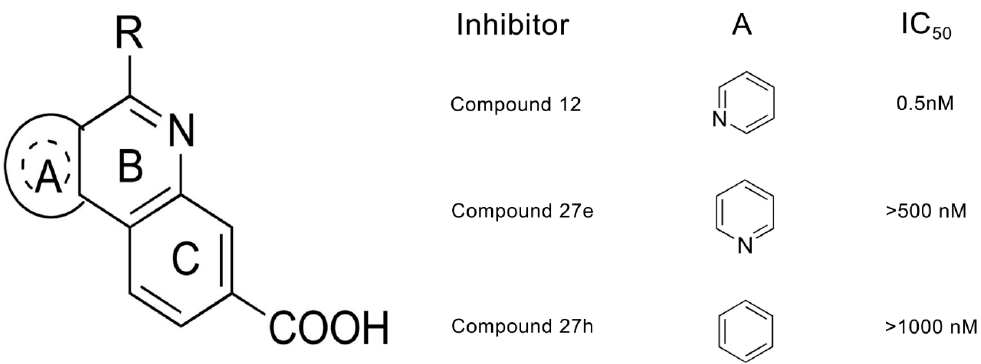
Figure 6. Chemical structures and IC 50 values of the tricyclic quinolone analogs 12 (R = 3-chlorophenyl), 27e (R = phenylamino) and 27h (R = phenylamino).